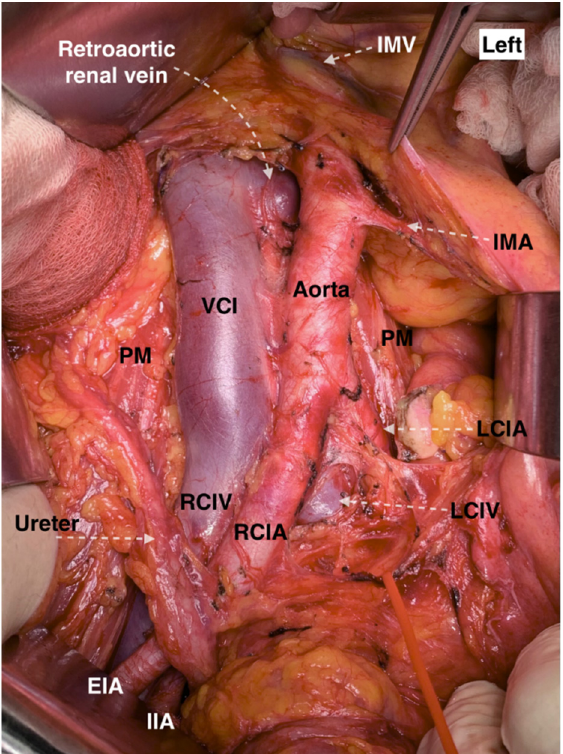
Figure 15. Retroaortic left renal vein at the aortocaval region (open surgery performed by Ilker Selcuk). VCI—vena cava inferior, IMA—inferior mesenteric artery, PM—psoas major muscle, LCIA—left common iliac artery, LCIV—left common iliac vein, RCIA—right common iliac artery RCIV—right common iliac vein, EIA—external iliac artery, IIA—internal iliac artery, IMV—inferior mesenteric